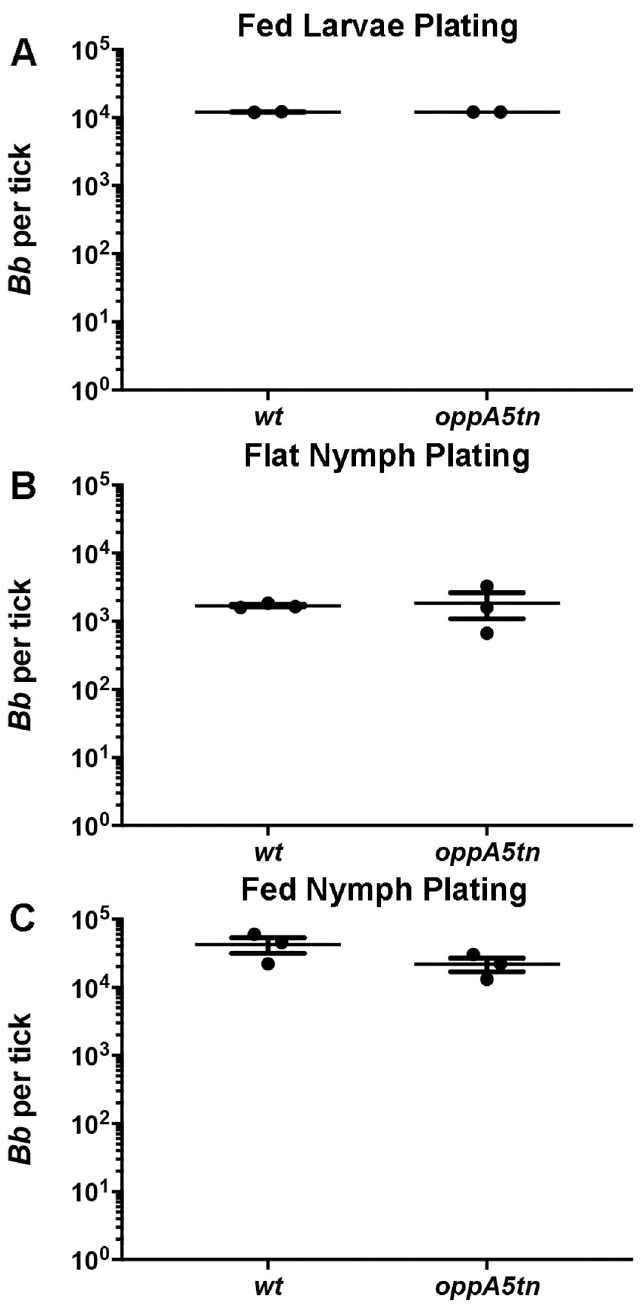
Fig 7. oppA5 is dispensable in ticks. (A) Colony counts (mean ± SEM) of midguts from larvae immersion fed with wt and oppA5tn , (B) subsequent molted flat nymphs, and (C) fed nymphs. Each data point represents a separate pool of ticks. Statistical analysis was determined by unpaired Student’s t